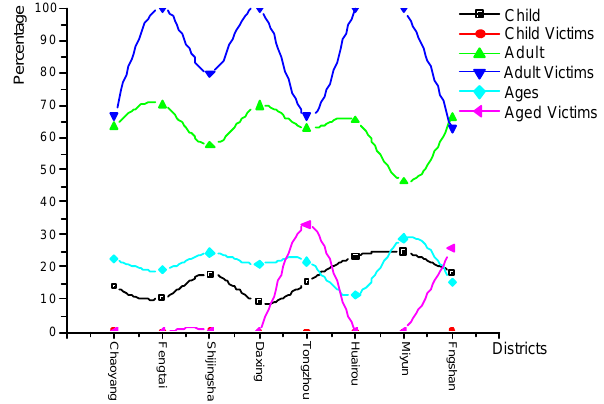
Fig. 10. The age distribution of population and victims in the eight affected districts